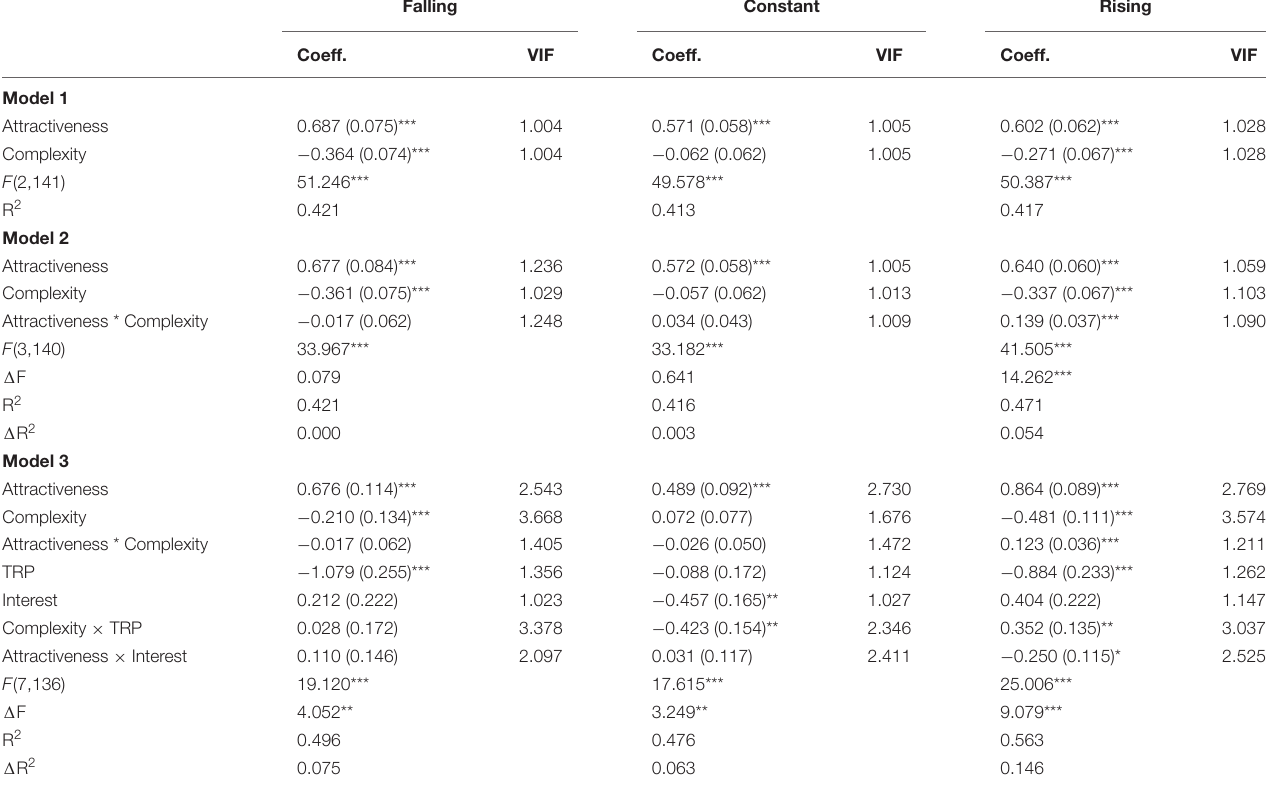
TABLE 6 | Regression